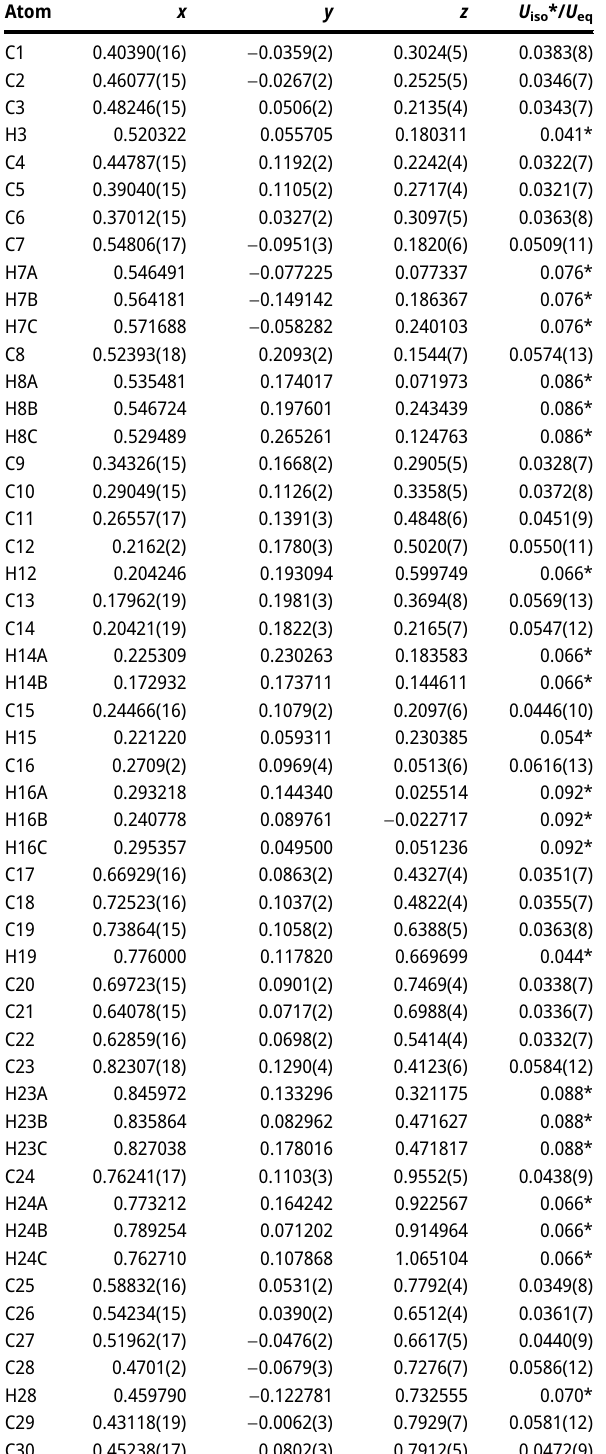
Table  : Fractional atomic coordinates and isotropic or equivalent isotropic displacement parameters (Å 